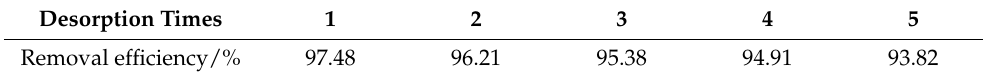
Table 4. Reuse of